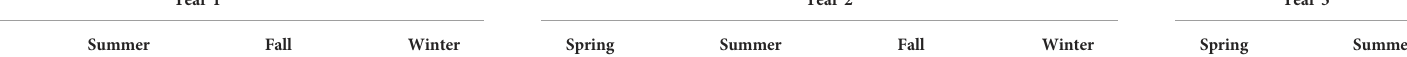
TABLE 1 Deployment schedule for period 1: Spring = deployed in February and retrieved in May; Summer = deployed in May and retrieved in August; Fall = deployed in August and retrieved in November, Winter = deployed in November and retrieved in February. Period